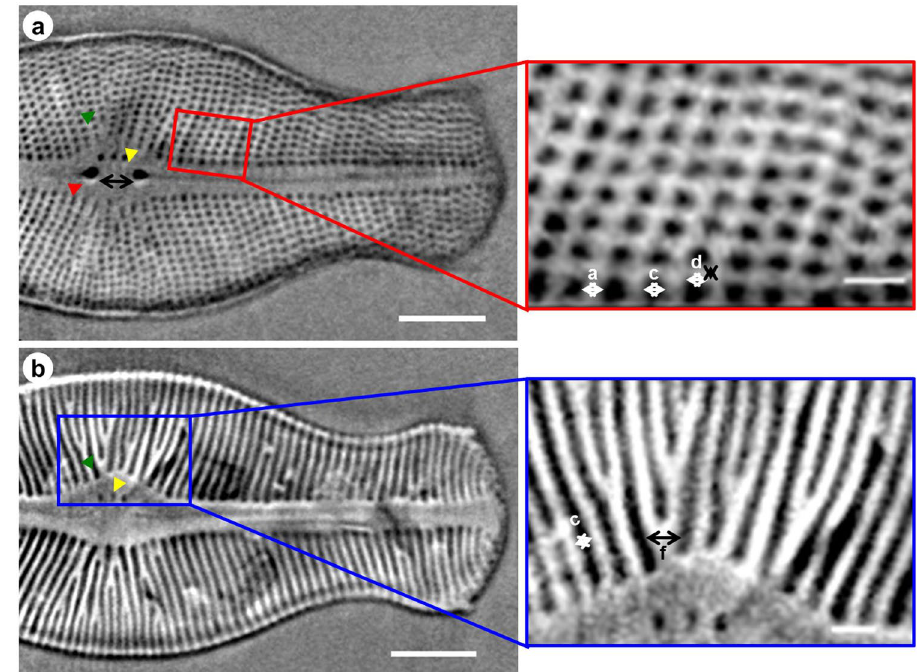
Figure 4. ( a , b ) Nano-XCT results of the valve view of the frustule of D. geminata from the surface to the valve interior in the Z direction (one slice extracted from the reconstructed 3D volume). Insets: zoomed regions of ( a ) ( red rectangle ) and ( b ) ( blue rectangle ). Red arrowheads : raphe, green arrowheads : ribs, yellow arrowheads : stigmas, white and double arrows : width, height, and distance of the ribs and struts. Scale bars: 10 µ m ( a , b ); 2 µ m (insets).